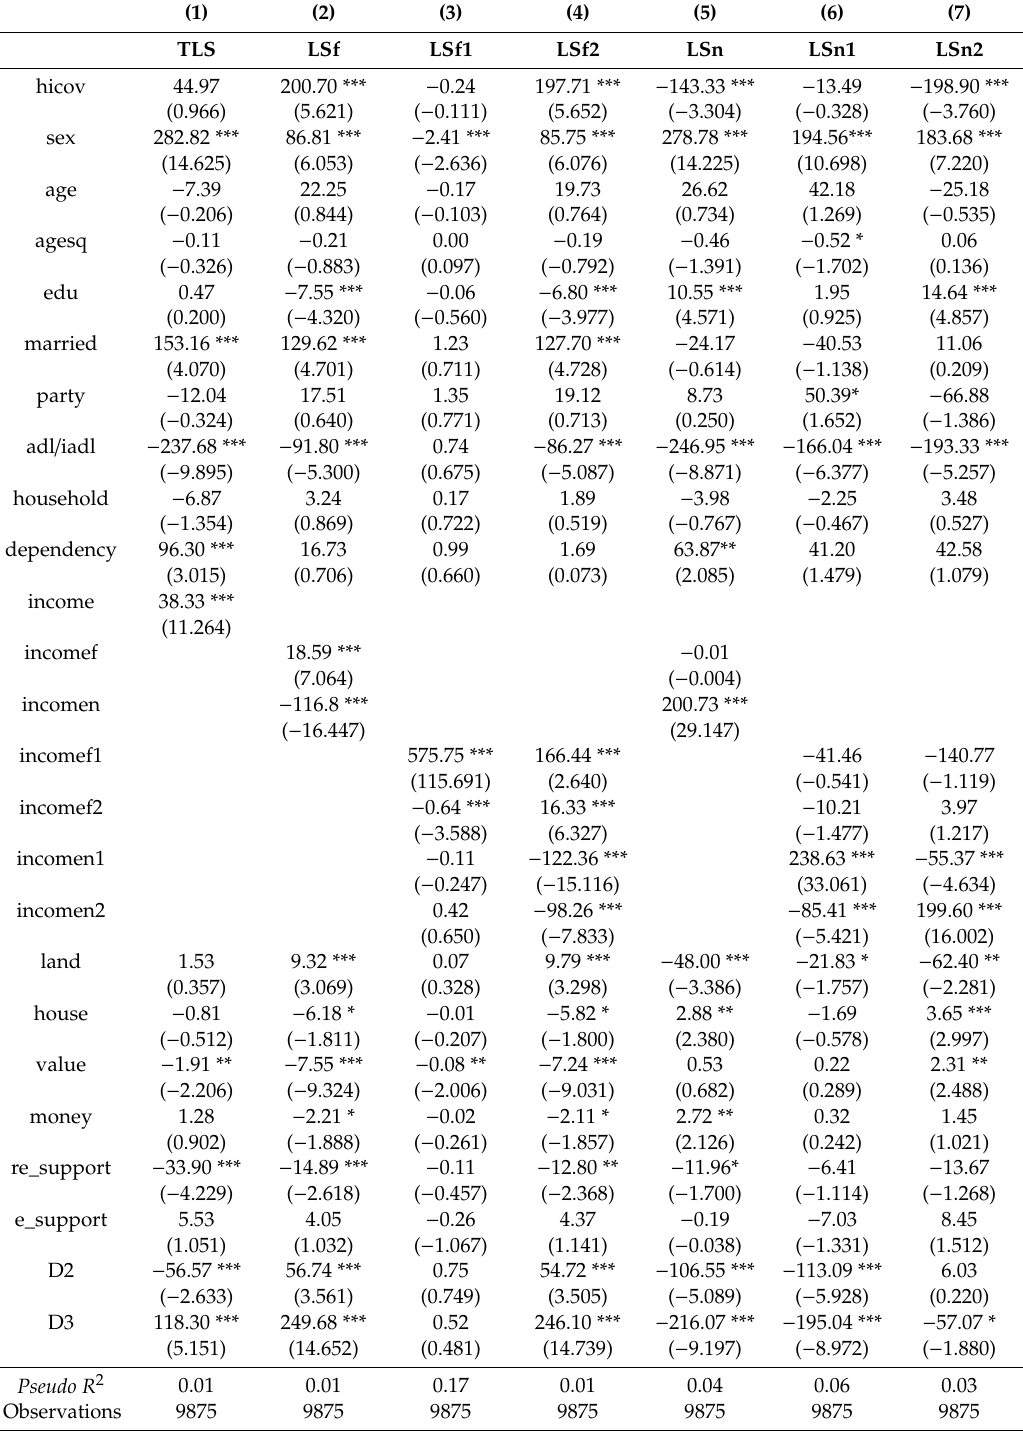
Table 11. Estimation of labor supply model for health